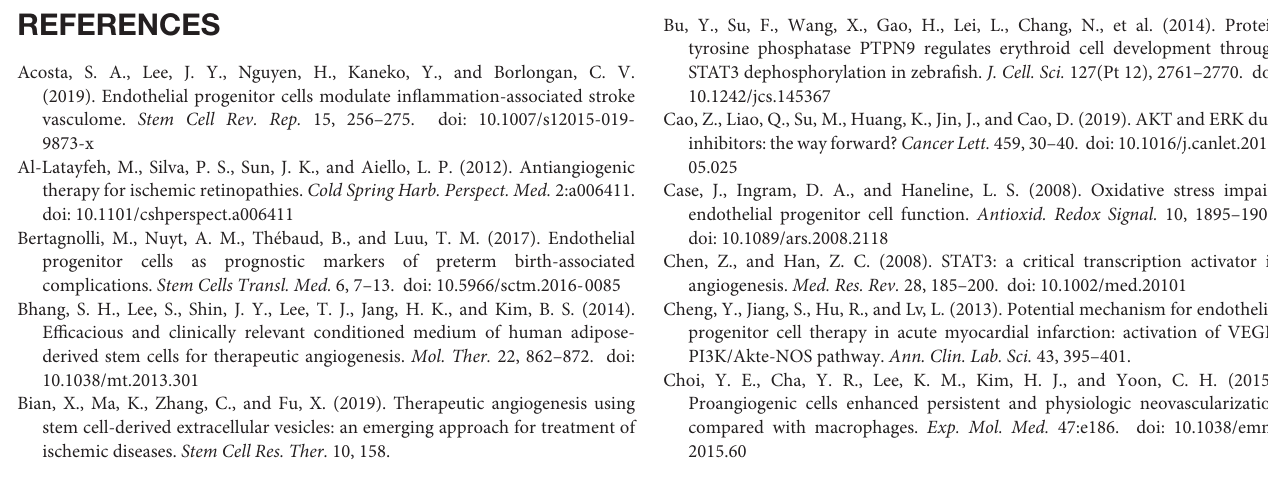
Supplementary Table 1 | List of primers used for real time